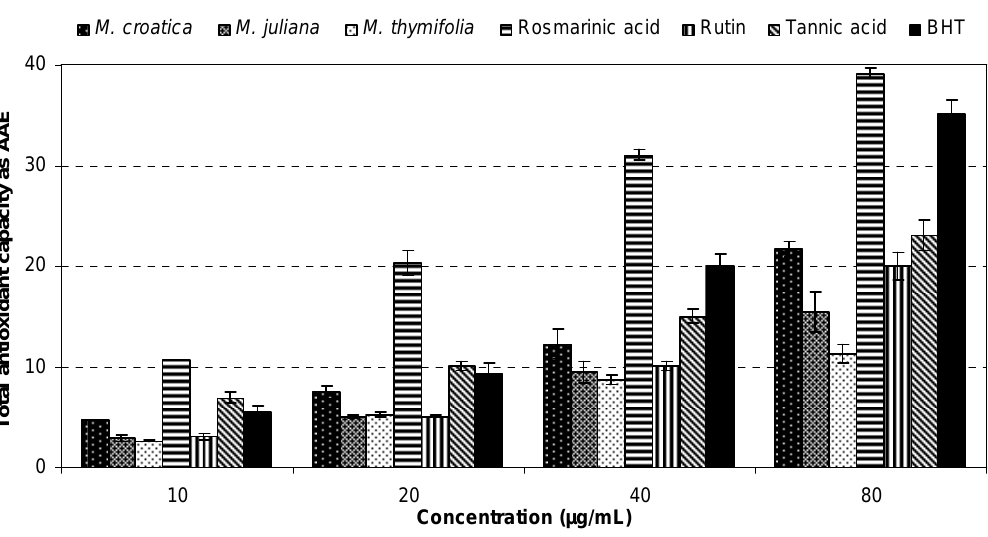
Figure 6. Total antioxidant capacities of Micromeria ethanolic extracts in comparison with polyphenolic compounds and a reference